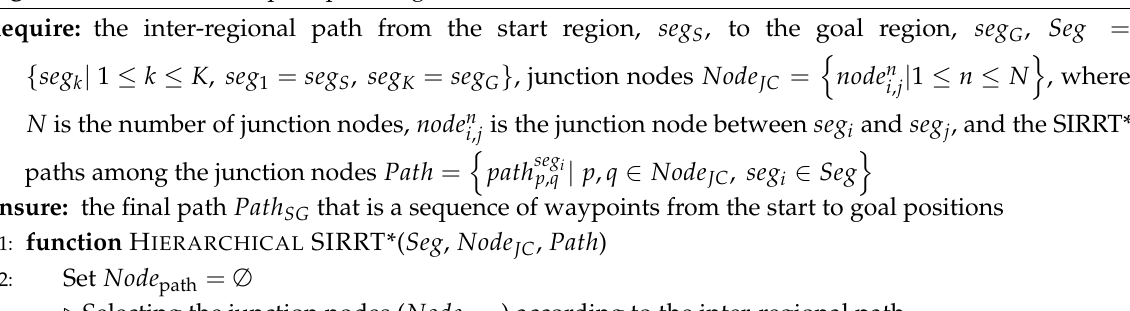
Algorithm 2 Hierarchical